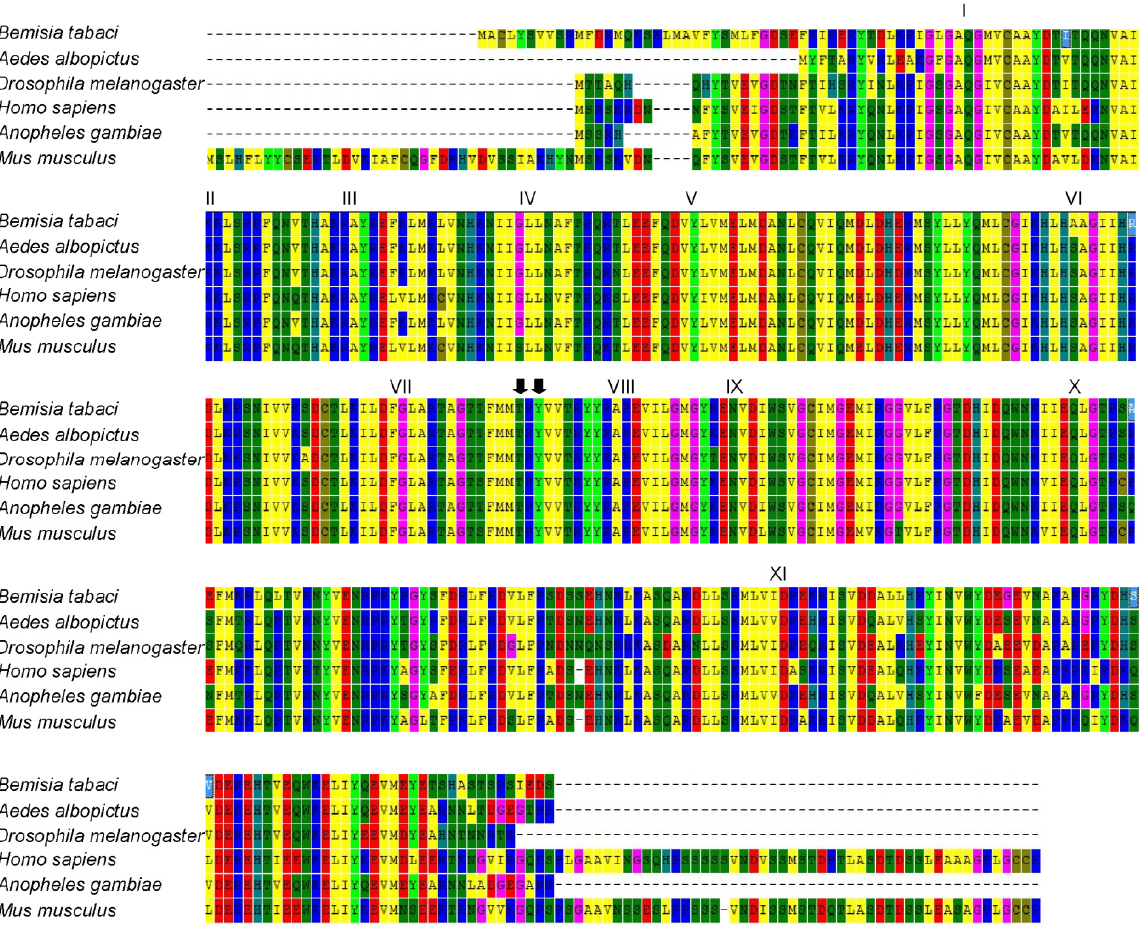
Figure 2. Multiple sequence alignments of JNKs from a variety of species. The amino acid sequence of Bemisia tabaci JNK was compared with those of other species. Black arrow indicates the phosphorylation sites on Thr and Tyr. The kinase subdomains are marked with roman numerals above the